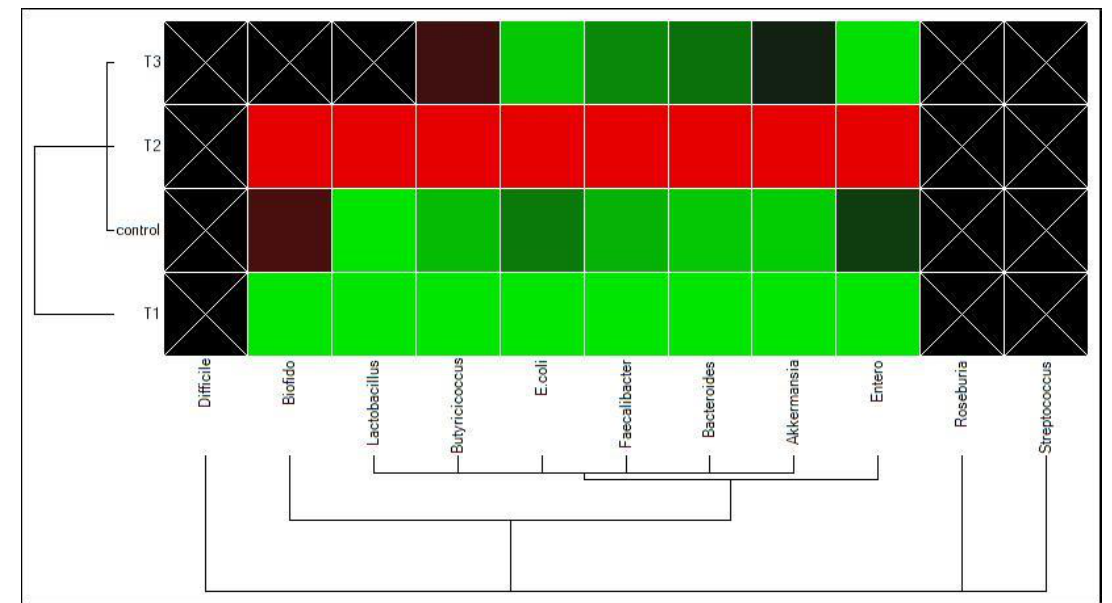
Figure 1. Clustergram of samples and targets in post-hatch chicks (day 35). The data colors indicate greater expression (upregulated — red color), lower expression (downregulated — green color) and no change in expression (no change in regulation — black color). The lighter the color, the greater the expression level determined by CFX96 Touch real-time PCR. C = control diet; T1 = black cumin seed meal 10%; T2 = coconut meal 10%; T3 = 5% black cumin seed meal and 5% coconut meal.